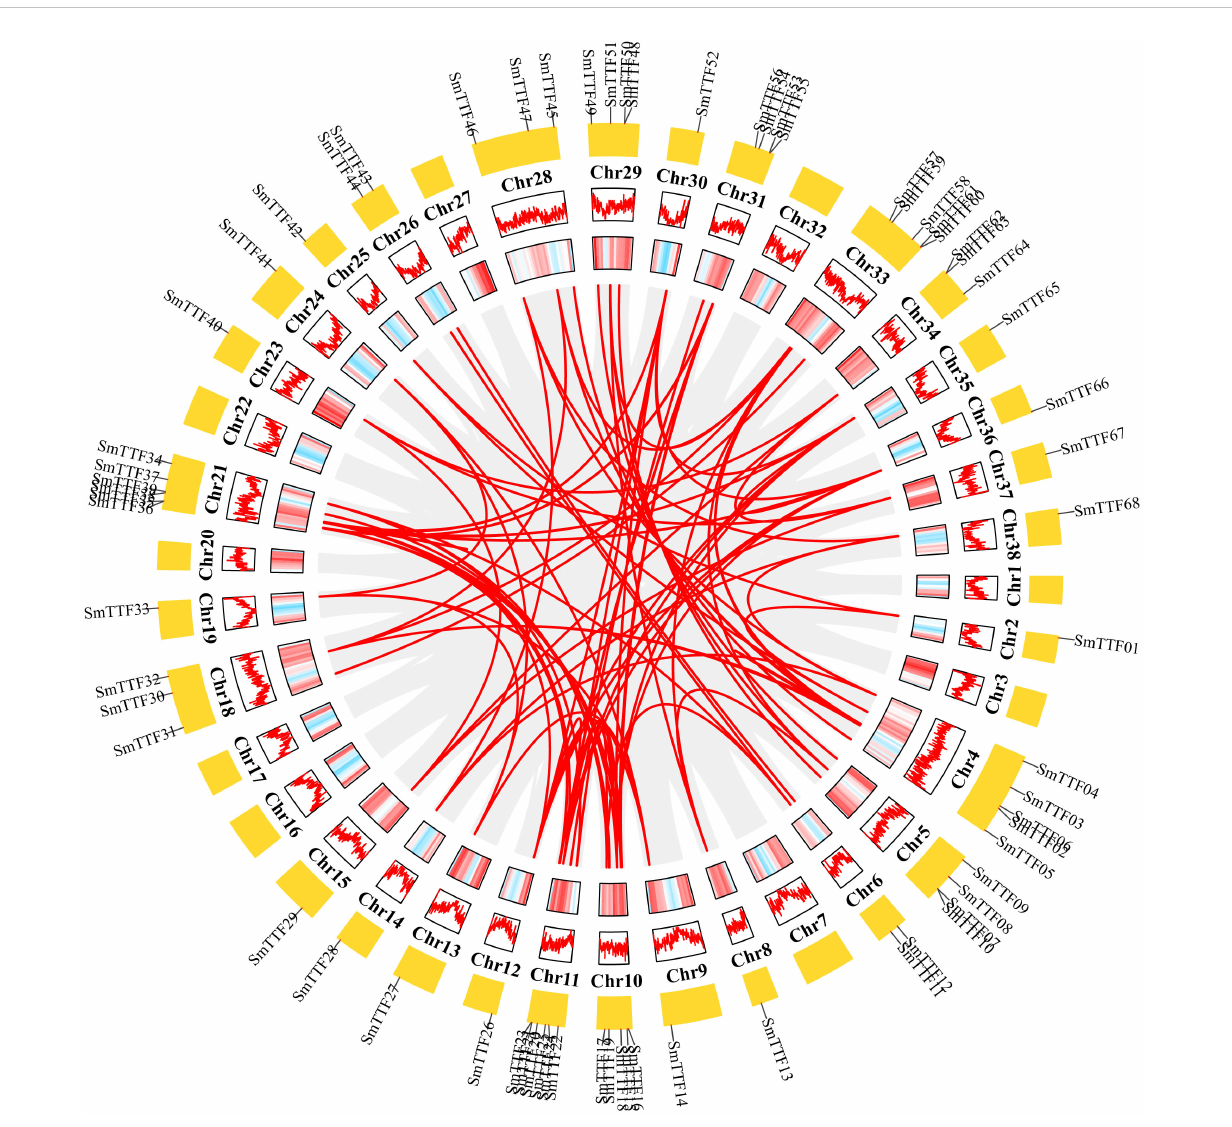
FIGURE 4 Schematic representations of the segmental duplication and interchromosomal relationships of SmTTF genes. Gray lines indicate all syntenic gene pairs in the S. matsudana genome, and red lines indicate syntenic relationships between SmTTF genes. Gene density across chromosomes is indicated by a hot map (inner circle) and column map (medium circles), and the outer circle shows the length of